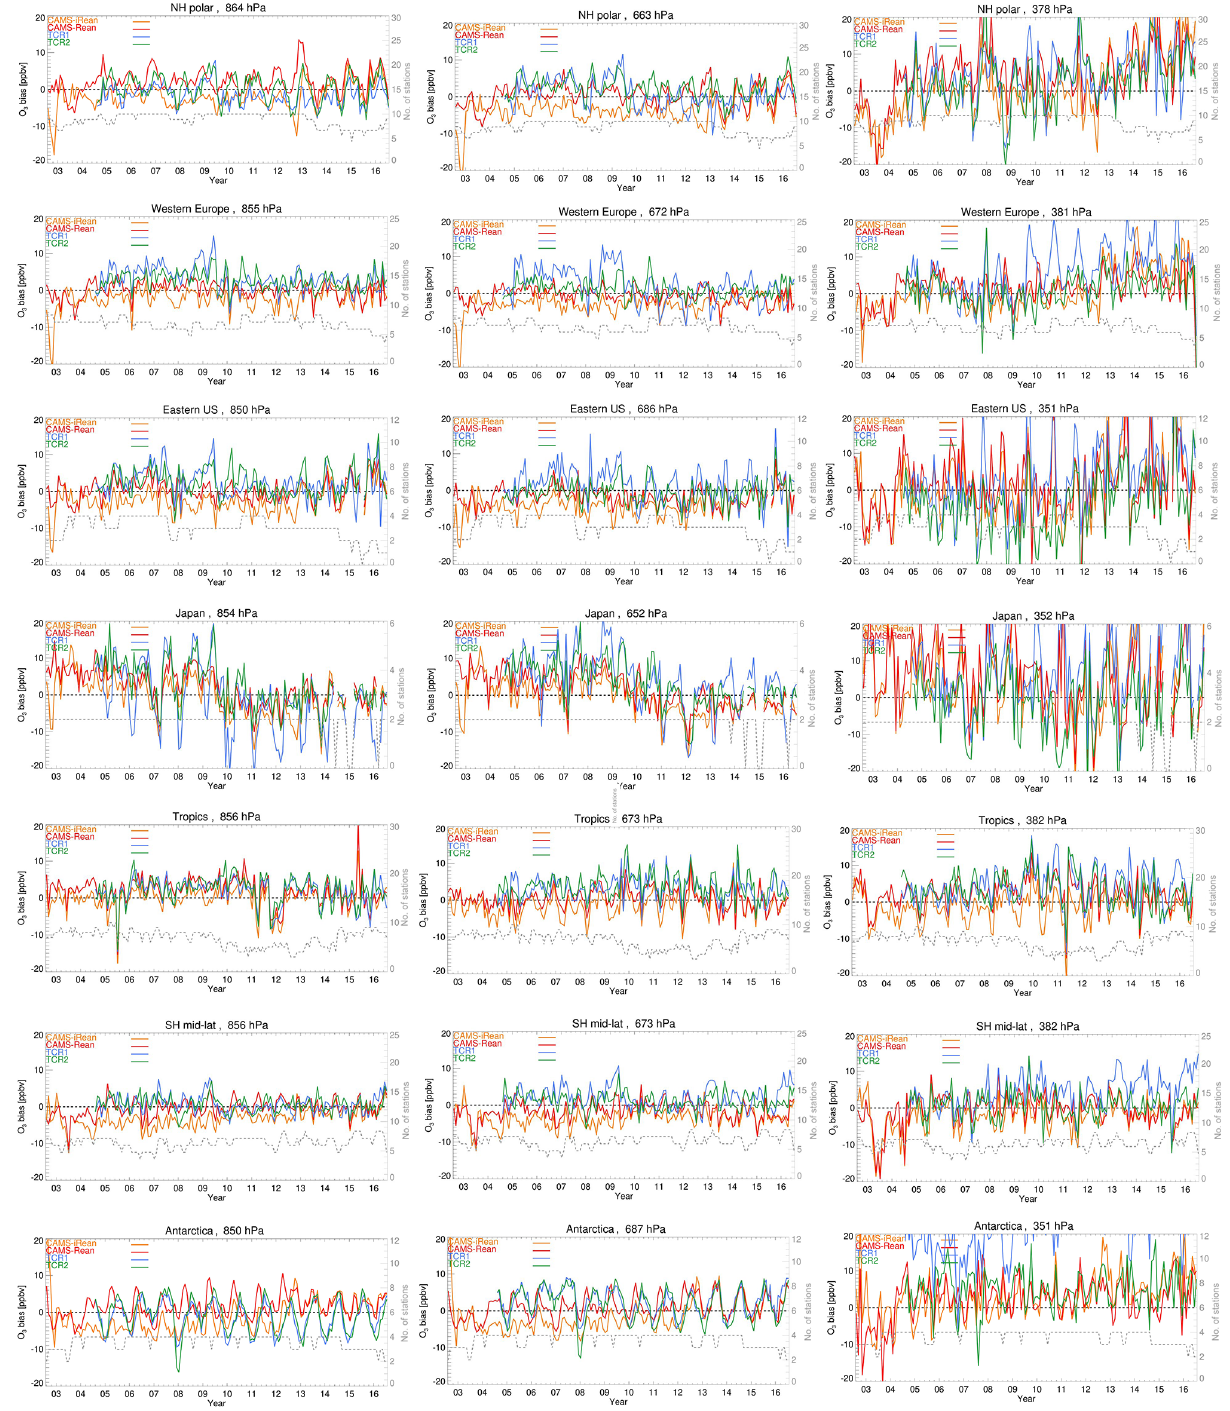
Figure 6. Time series of regionally and monthly aggregated ozone biases at different altitudes (850, 650, and 350hPa) sampled at ozone- sonde locations. As in Fig. 4, the dashed grey line refers to the number of stations that contribute to the statistics (right vertical